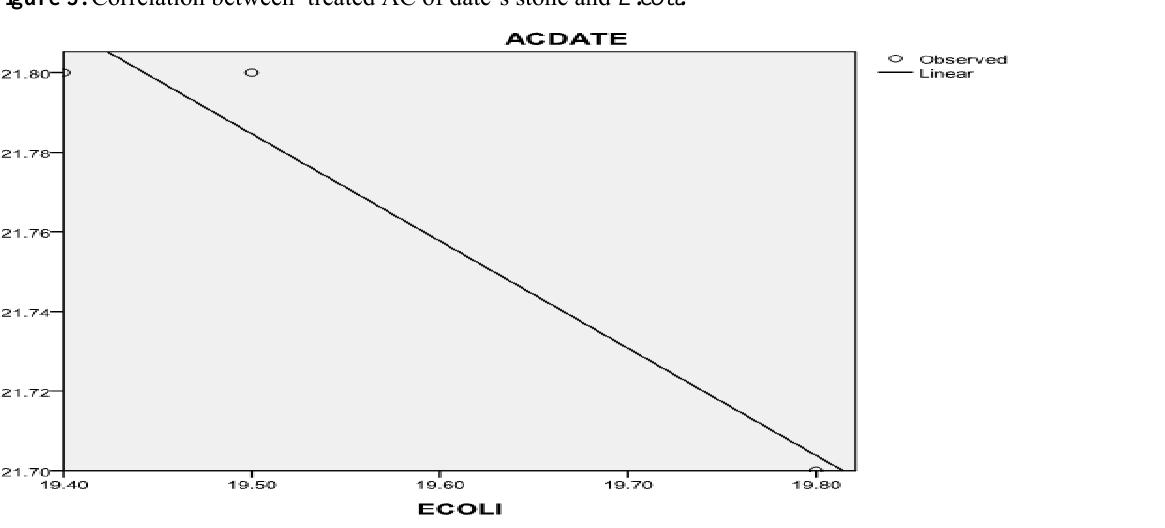
Figure 5. Correlation between treated AC of date’s stone and